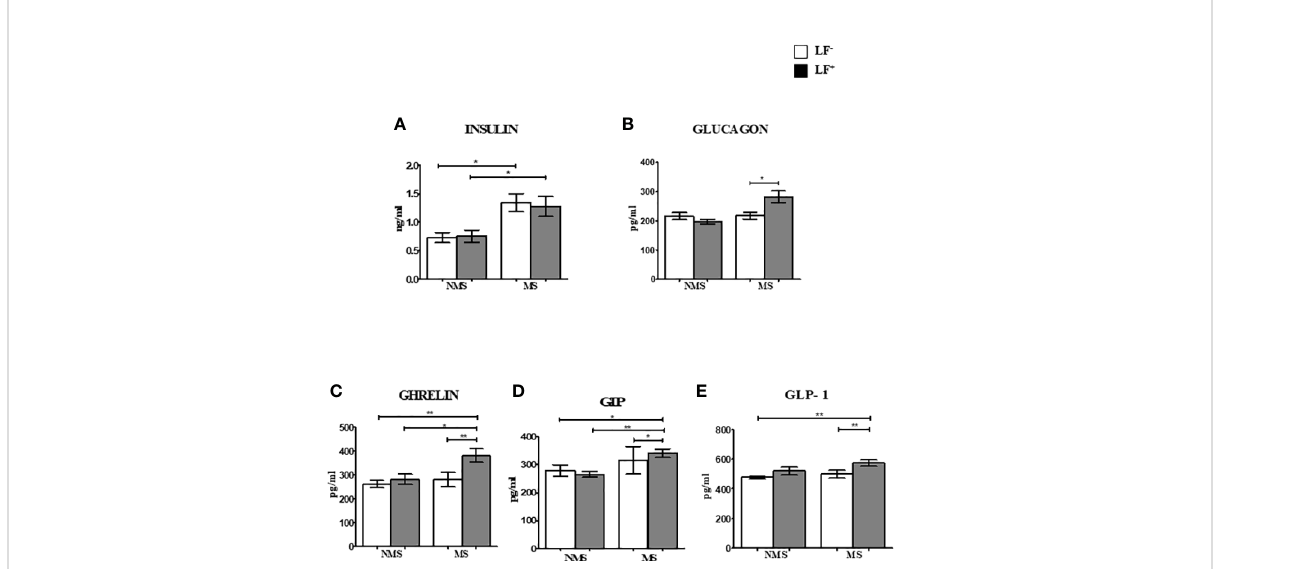
FIGURE 1 Baseline circulating levels of pancreatic and gut hormones in MS-LF study groups. Bar with error bars represent the mean ± SD of levels of insulin (A) , glucagon (B) , ghrelin (C) , GIP (D) , GLP-1 (E) , in the serum of the study subjects. The levels of pancreatic and gut hormones were estimated by Bio-Plex Pro Human Diabetes 10-Plex Assay. Statistical signi fi cance was determined by non-parametric Mann-Whitney U test and p<0.05 was considered signi fi cant. *p<0.05;**p<0.01.